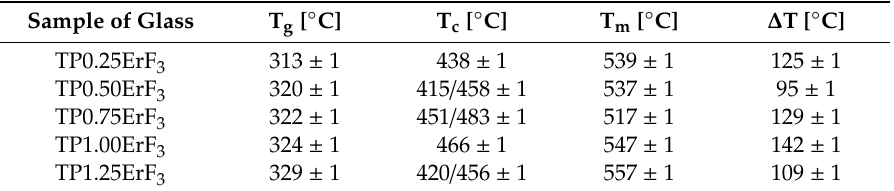
Table 1. Glass transition (T g ), crystallization (T c ), melting (T m ) temperatures, and thermal stability ( ∆ T) of erbium-doped phospho-tellurite glass. Sample of